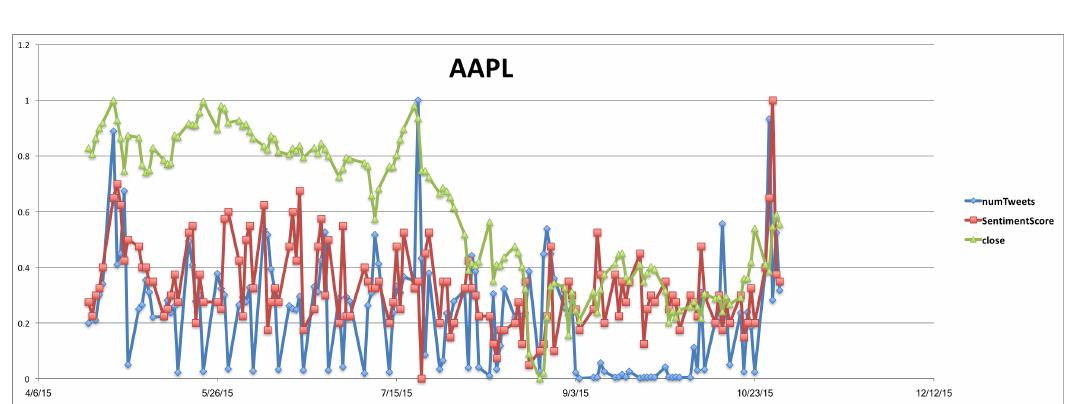
Figure 4. Time series of close, sentimentScore and numTweets about AAPL. Normalization into [0, 1]